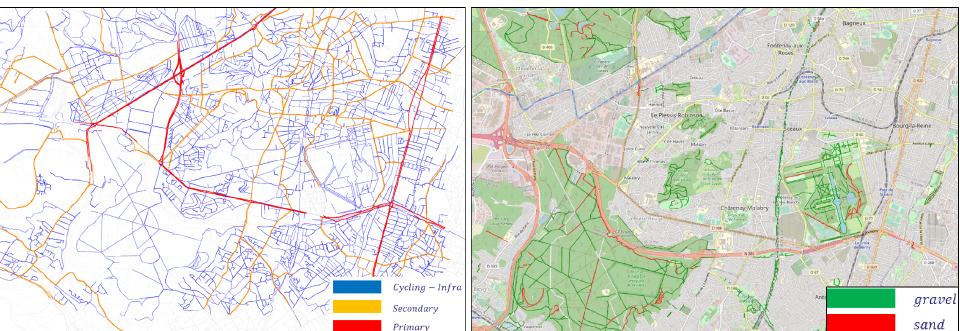
Figure 5. ( Left ): Elevation map: from 50 m to 200 m from sea level. ( Right ): bicycle roads slope.